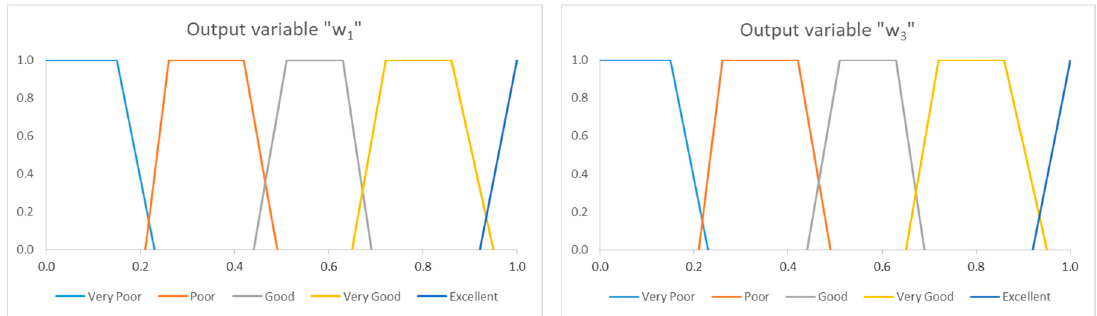
Figure 5. Output membership functions.